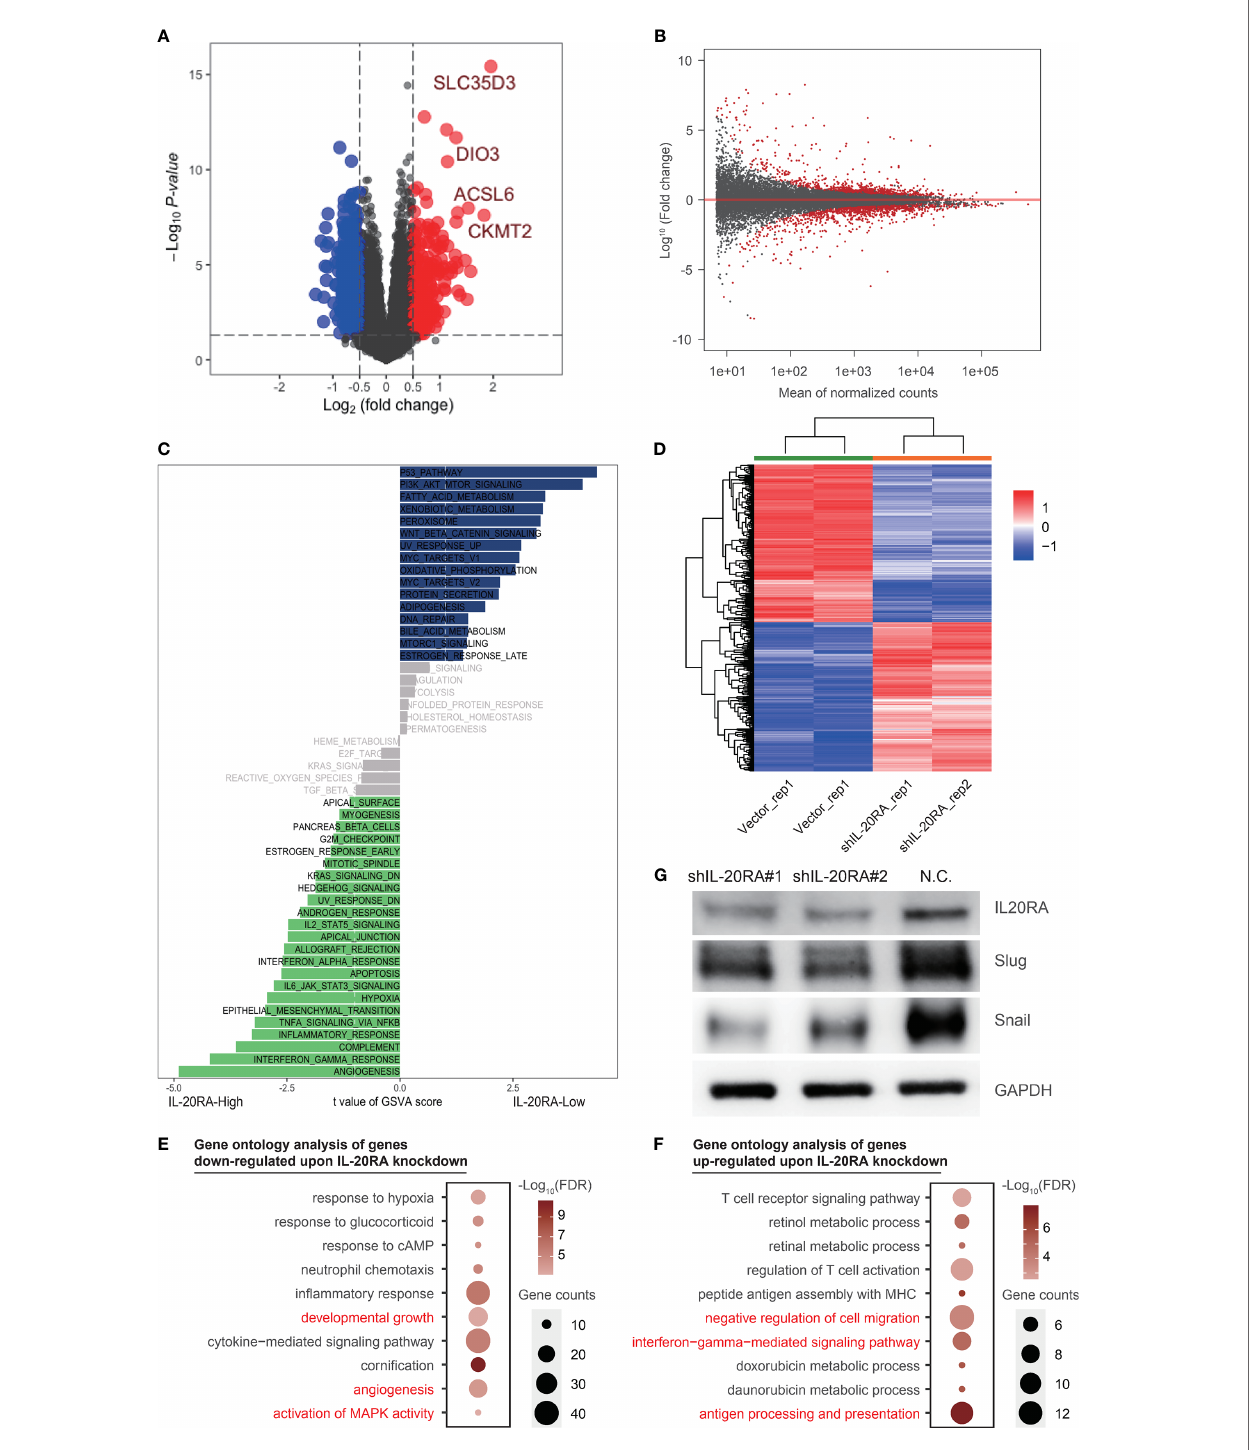
FIGURE 4 | IL-20RA was associated with oncogenic and immune pathways. (A, B) Differently expressed genes showed by volcano plot using TCGA-COAD datasets and RNA-seq. (C) IL-20RA-related pathways were analyzed with Gene set variation analysis. (D) Heatmap showed genes differentially expressed in LoVo cells with or without IL-20RA knockdown. (E, F) Gene ontology analysis of genes down- (E) and up-regulated (F) post-IL-20RA knockdown. (G) Expression of IL-20RA, Snail and Slug at the protein level in shIL-20RA LoVo cells detected by immunoblotting. The data were obtained from 3 independent experiments and the presented as the mean ± SD (GAPDH was used as a loading